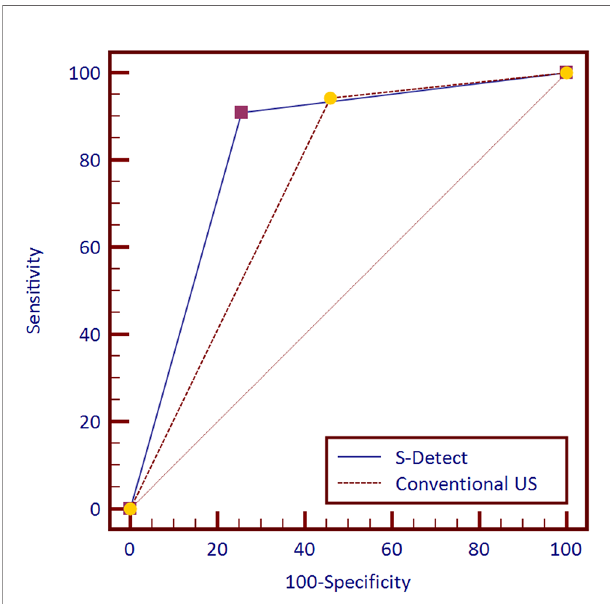
FIGURE 2 | Receiver operating characteristic (ROC) curves of S-Detect and the conventional ultrasound (US) for 757